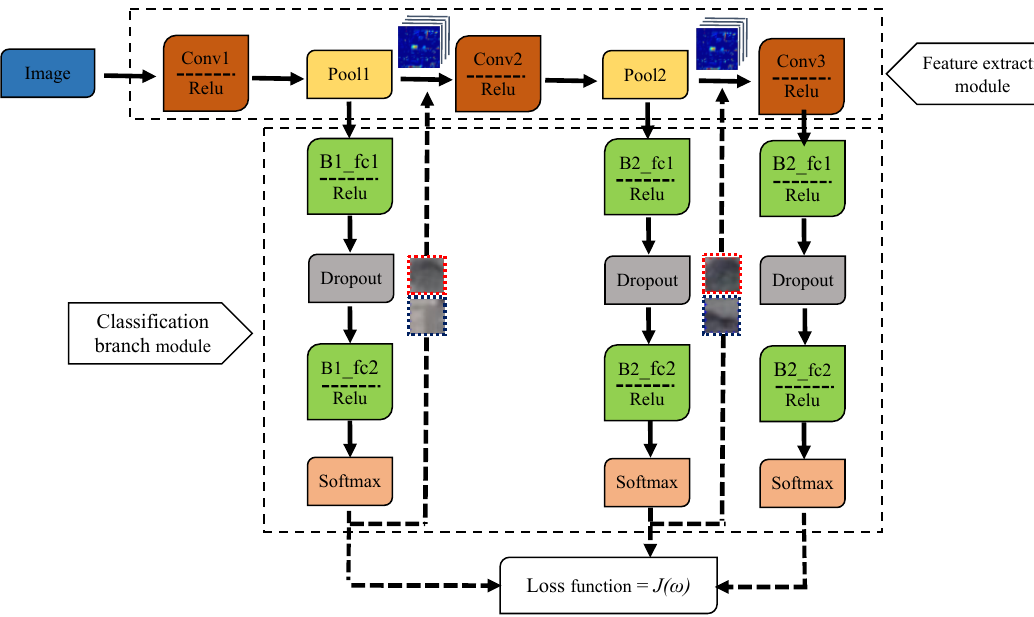
Figure 5. Progressive cascaded convolutional neural